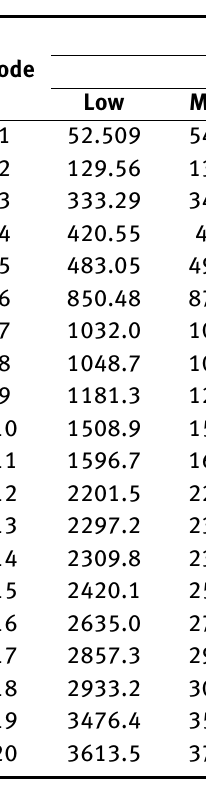
Table 7: Natural frequencies of low-carbon steel, marine, and ice-class materials on different